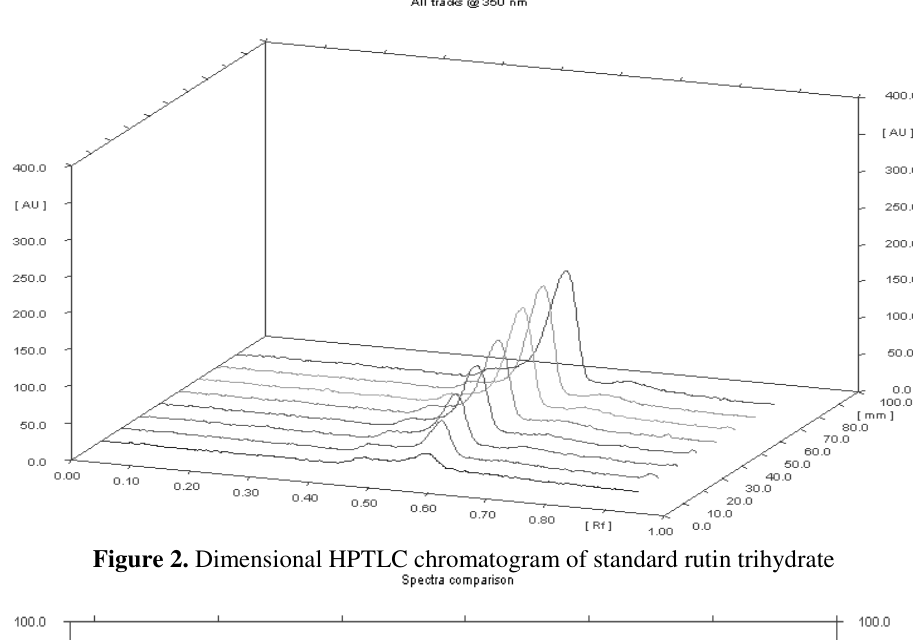
Figure 2. Dimensional HPTLC chromatogram of standard rutin trihydrate